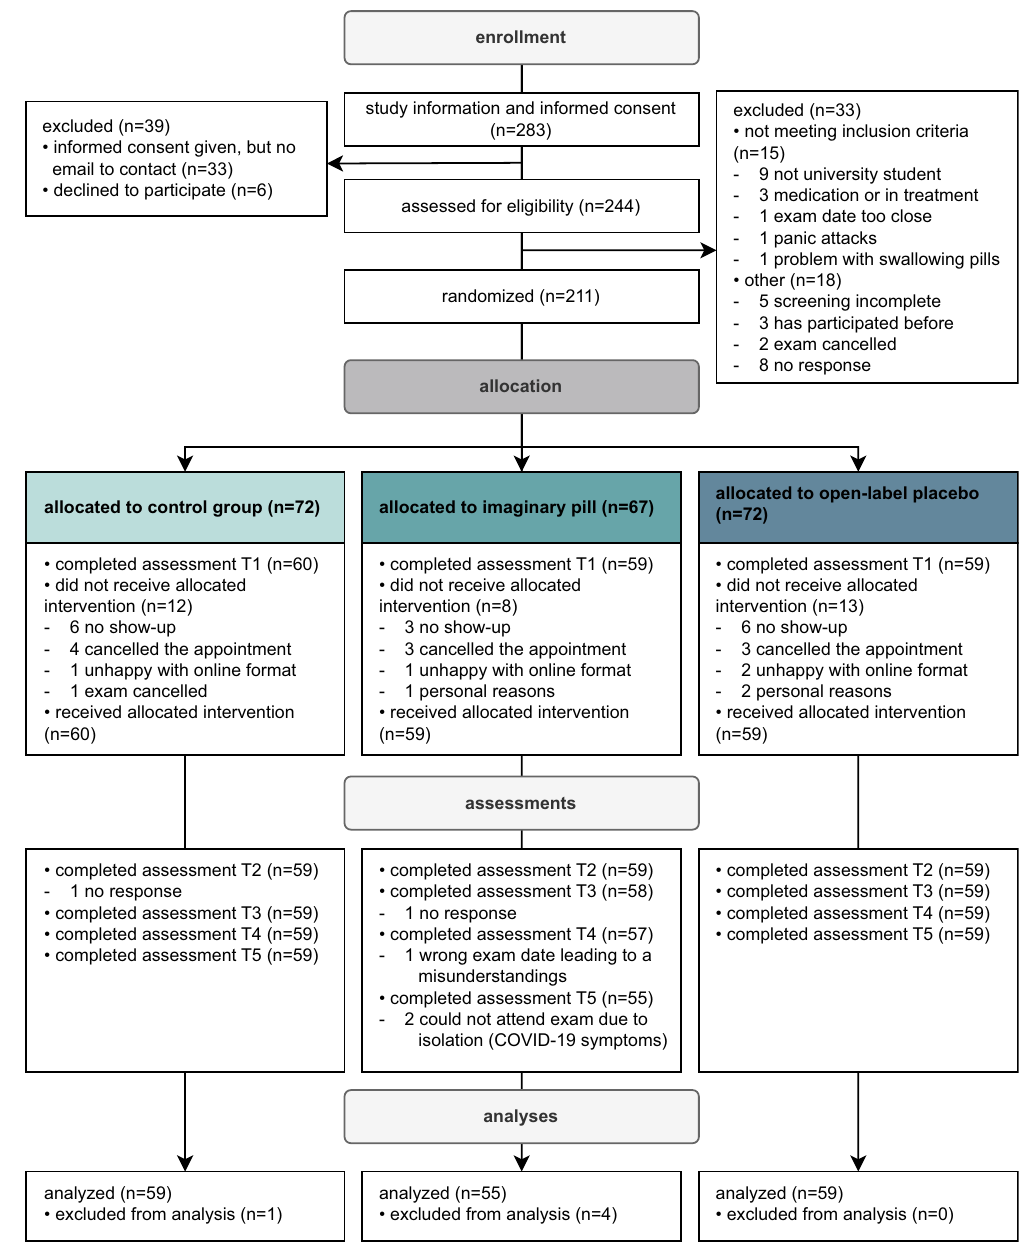
Figure 1. CONSORT diagram. Flow of the study, including reasons for exclusions.